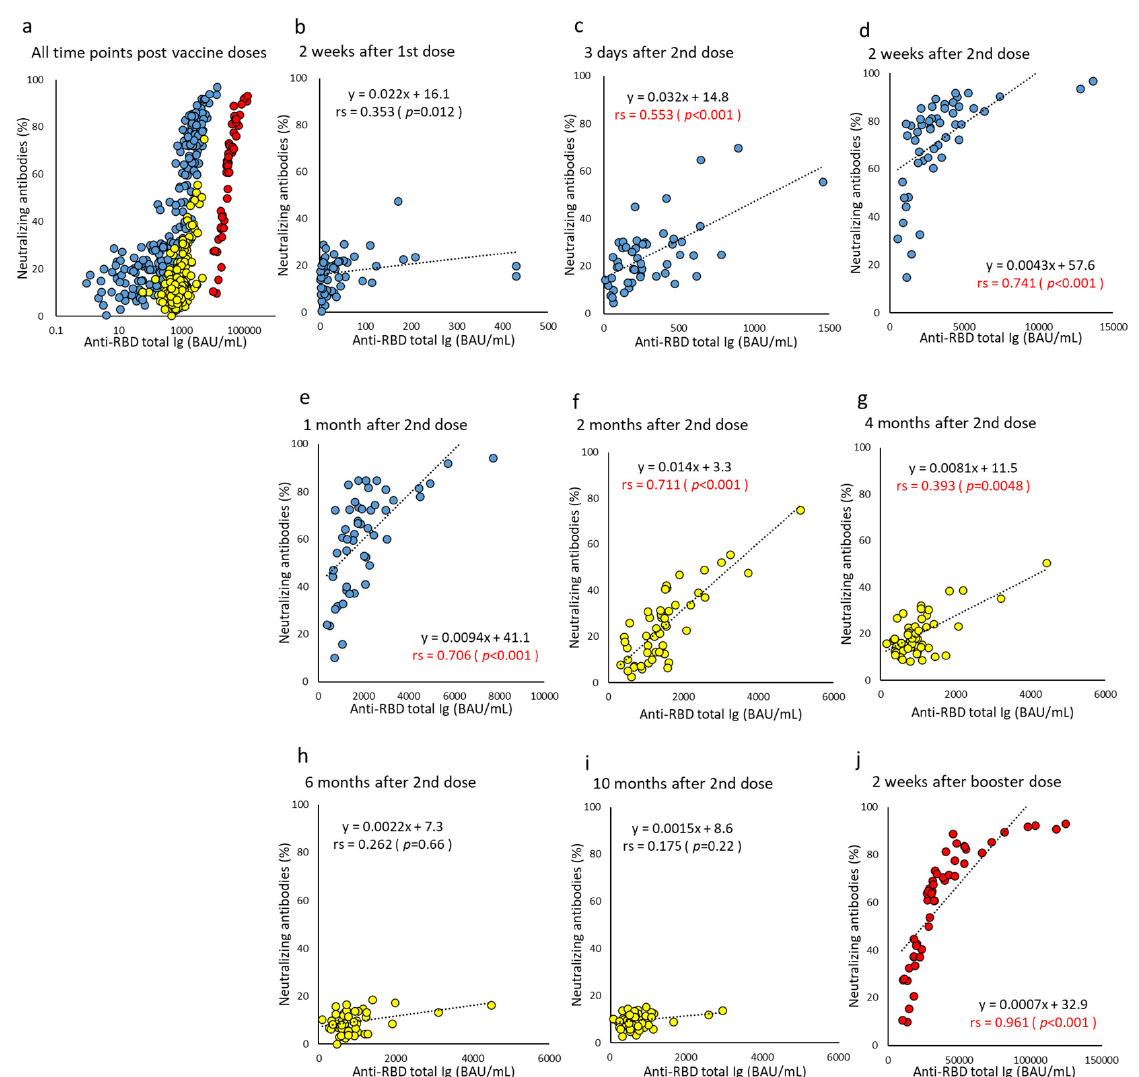
Figure 6. ( a – j ). Correlation at time points between anti-RBD total Ig and neutralizing antibodies after BNT162b2 vaccine doses. The levels of parameters indicating anti-RBD total Ig and neutralizing antibodies of humoral immunity are plotted, and the correlation is compared using all or each time point post-vaccine doses. Antibody titers at all time points are indicated on a log scale ( a ). Time points until one month after two doses are represented by blue ( b – e ), from two months to 10 months after two doses are represented by yellow ( f – i ), and two weeks after the booster dose are represented by red ( j ). p -values were calculated using Spearman’s rank correlation test, and significance was set at 0.01. Red values indicate a significant correlation (rs, Spearman’s rank correlation